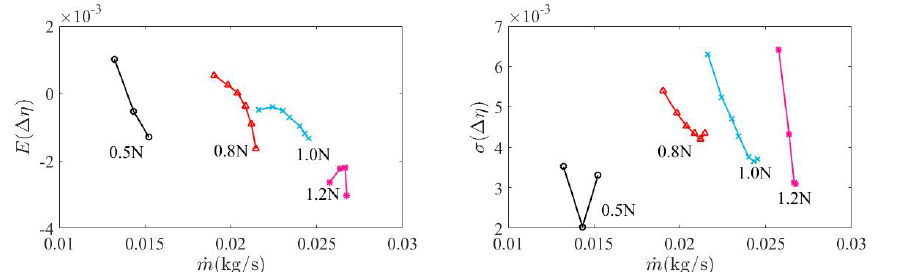
Figure 24. Uncertainty statistics of